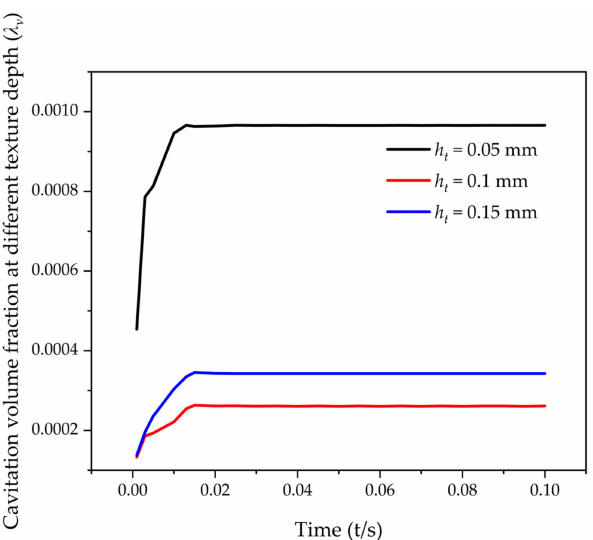
Figure 23. Effect of texture depth on oil film cavitation.